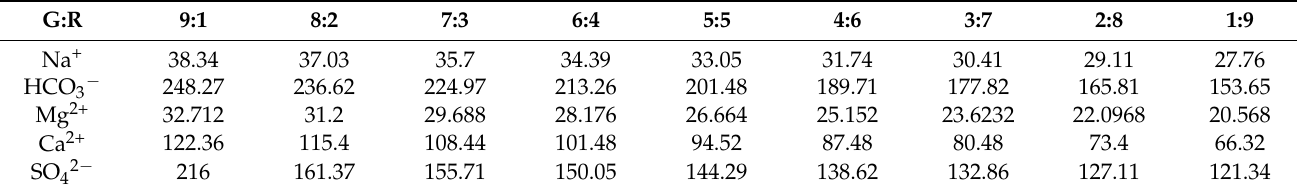
Table 4. Simulation Results of Main Ion Components in Different Ratios (mg/L).